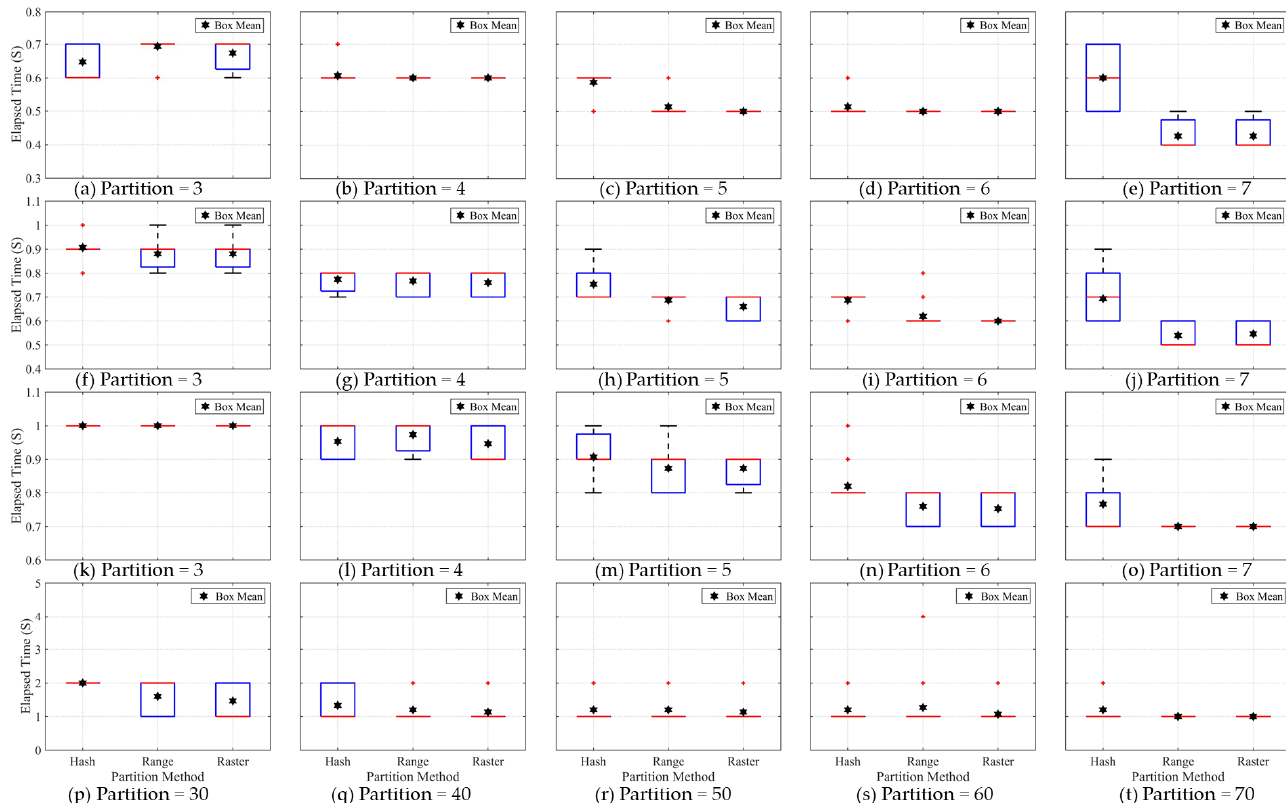
Figure 9. The elapsed time for the data shuffle